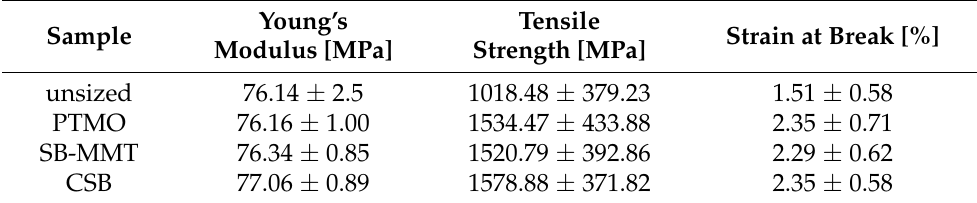
Table 3. Mechanical properties of the IPF AR-glass fibers, unsized, sized with PTMO, and coated with either SB-MMT or CSB.